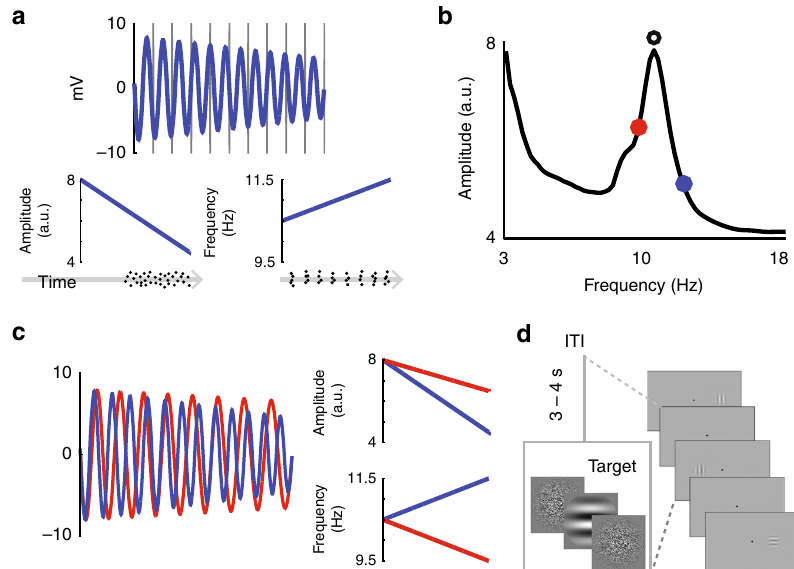
Fig. 1 Hypothesis and task design. a A simulated example of an alpha oscillation that is both increasing in frequency and decreasing in amplitude over time, as exempli fi ed in the left and right plots underneath, respectively. Verticle lines indicate evenly spaced time bins matching one cycle of the initial oscillatory frequency. Plotted below the amplitude and frequency traces are hypothetical raster plots corresponding with periods of ef fi cient visual information processing according to the desychonization and instantaneous frequency hypotheses, respectively. b Amplitude spectrum from a representative subject. Note the general 1/f distribution of amplitude over frequency, and the pronounced bump in the alpha range. The circular outline indicates peak alpha frequency, whereas gray dots indicate hypothetical shifts away from the peak alpha frequency over the course of the trials outlined in c . c Along with the same example trial in b , now termed a correct trial, we have plotted a hypothetical incorrect trial that decreases in frequency and amplitude with magnitudes corresponding with the spectrum in c . Note that on the left side of the panel, the two traces are in phase, but become out of phase over the course of the trial, meaning frequency shifts could lead to offsets in phase through a relative speeding or slowing of the underlying signals. In addition to phase offsets, shifts in frequency away from peak alpha could also impact alpha amplitude as shown in the bottom right panel. d Task Design. The target was a Gaussian — windowed Gabor (mean contrast = 5%) presented for 8.3 ms. The target was immediately preceded and followed by one frame (~8.3 ms each) of gaussian — windowed white noise. Between target presentations, subjects passively fi xated at the center of a gray screen for 3000 – 4000 ms (uniform distribution of ITIs). Target location (centered 8.5° left or right from fi xation) was randomly selected with the only constraint that an equal number of trials were presented on both sides of fi